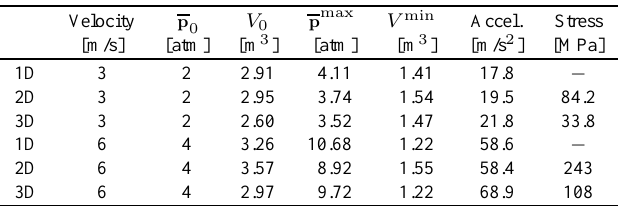
Table 2 Comparison of results obtained by using different models of